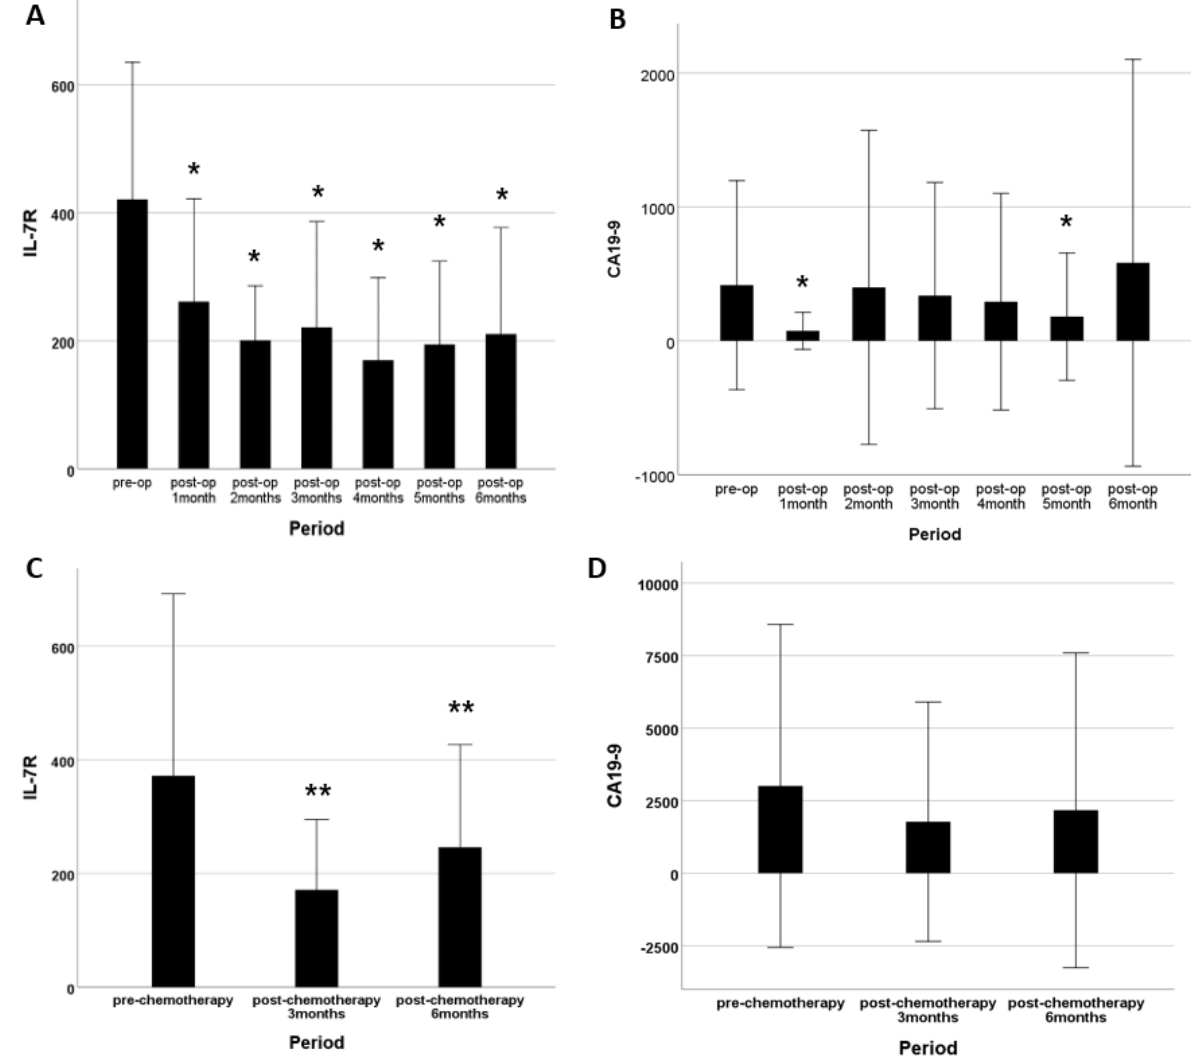
Figure 5. IL-7R and CA19-9 levels after PDAC treatment. ( A ) In the resectable PDAC group, the IL-7R level was lower than preoperatively at 6 months postoperatively. ( B ) In the resectable PDAC group, the CA19-9 level decreased immediately after surgery and fluctuated thereafter. ( C ) In the unresectable PDAC group, the IL-7R level was lower after chemotherapy relative to the pretreatment level. ( D ) In the unresectable PDAC group, the CA19-9 levels measured before and after chemotherapy did not differ. * p < 0.005 vs. preoperatively. ** p < 0.005 vs. before chemotherapy.